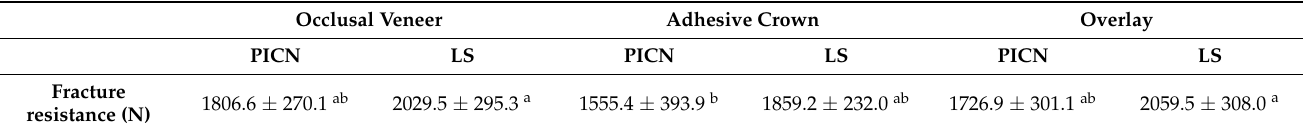
Table 3 lists the mean fracture resistance to static load, expressed in N, for the various groups. Table 3. Mean fracture resistance ± standard deviation, expressed as Newton, for each group. Same superscript letters indicate no significant differences.